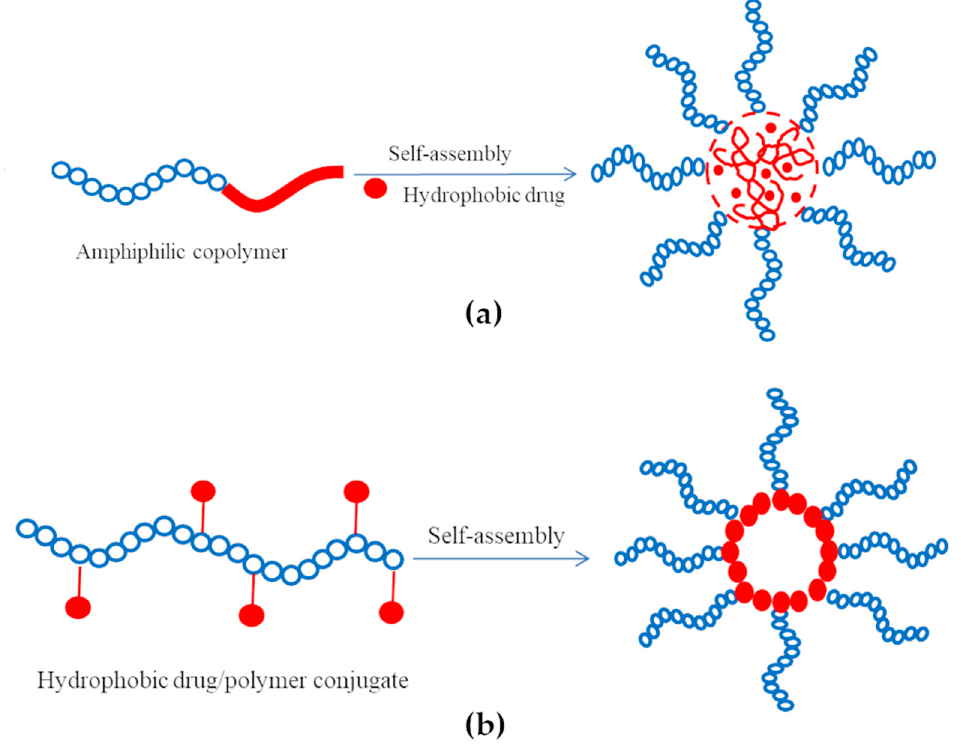
Figure 4. Schematic representation for the preparation of micellar drug delivery systems (DDS) by self-assembly; ( a ) physical drug entrapment; ( b ) self-assembly of drug/polymer conjugate formed by chemical or polyionic conjugation.